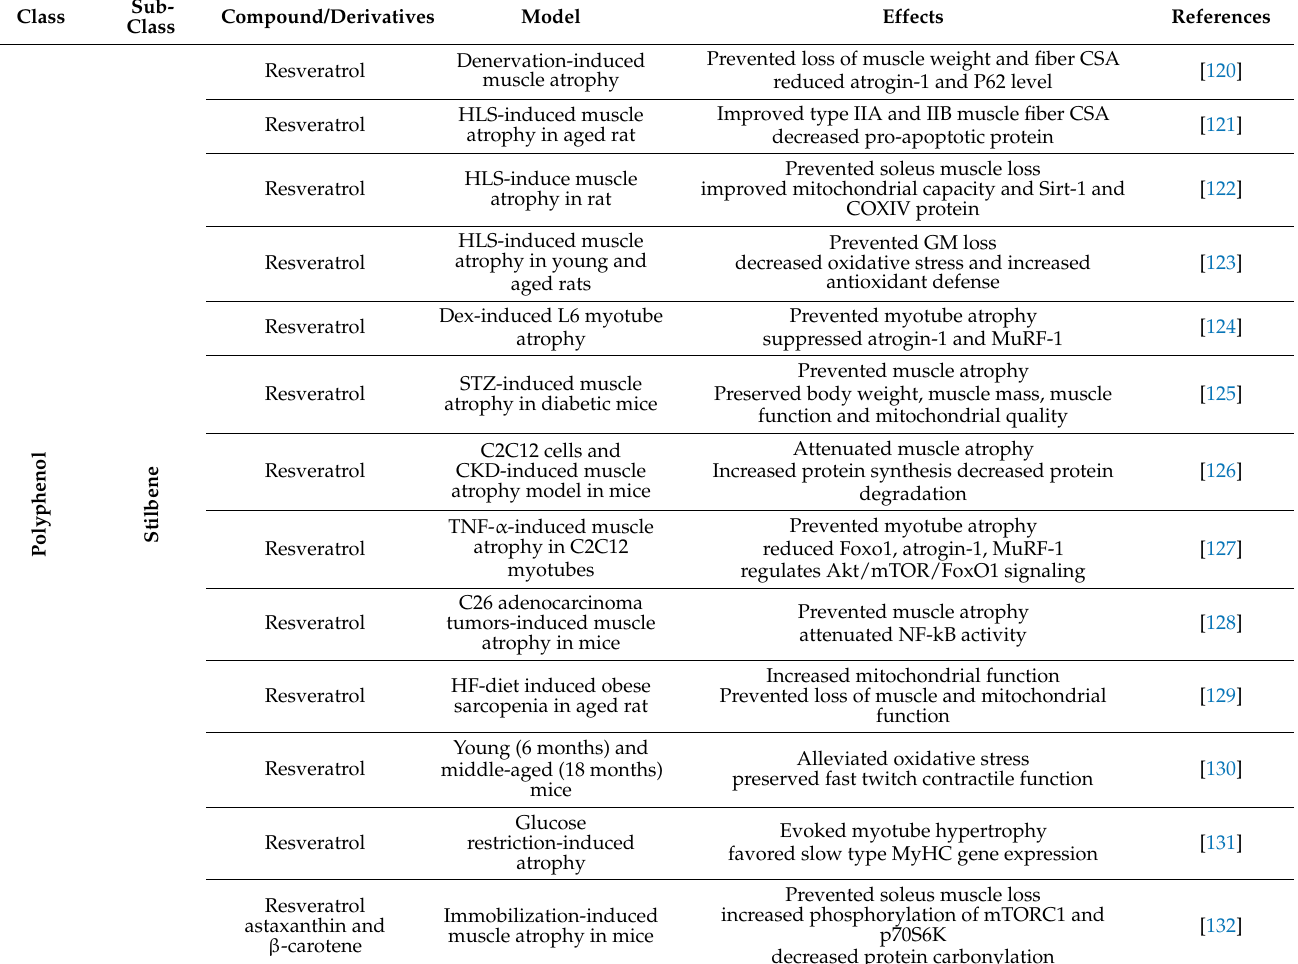
Table 3. Function of stilbene and its derivatives in promotion of muscle health and prevention of muscle atrophy. Class Sub- Class Compound/Derivatives